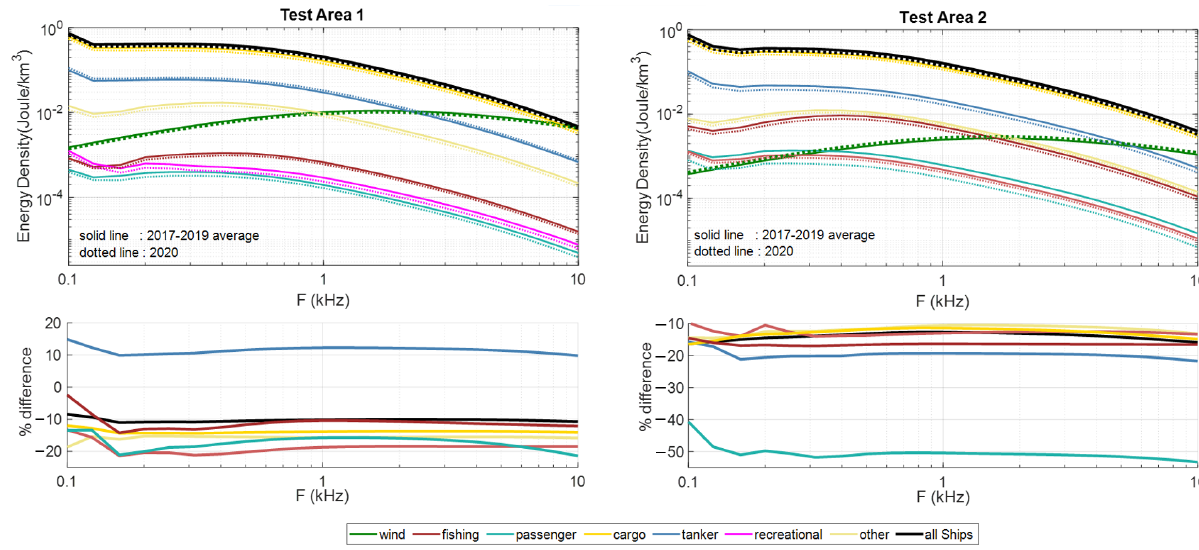
Figure 16. Comparisons of the energy densities of different ship categories and wind for test area 1 ( upper left ) and test area 2 ( upper right ). The percentage differences for each ship categories are shown for test area 1 ( lower left ) and test area 2 ( lower right